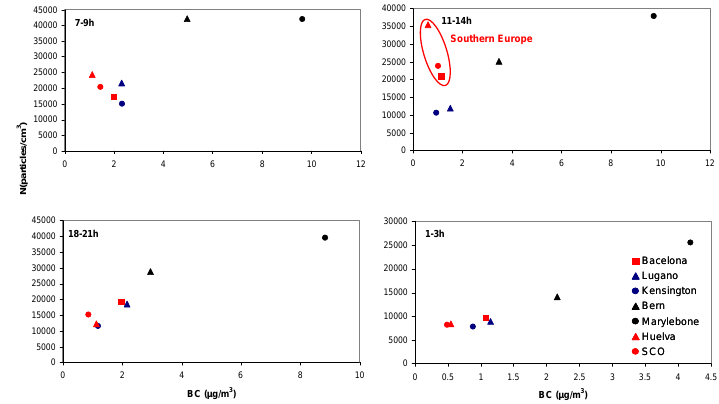
Figure 5. Correlation between: a) the mean annual hourly levels of N and BC for the 1160 Fig. 5. Correlation between: (a) the mean annual hourly levels of N and BC for the periods 07:00–09:00, 11:00–14:00, 18:00–21:00 and 01:00–03:00 (UTC) for the different study sites. Table 5. Values of S1 and S2 representing the minimum and maximum N/BC ratios for each